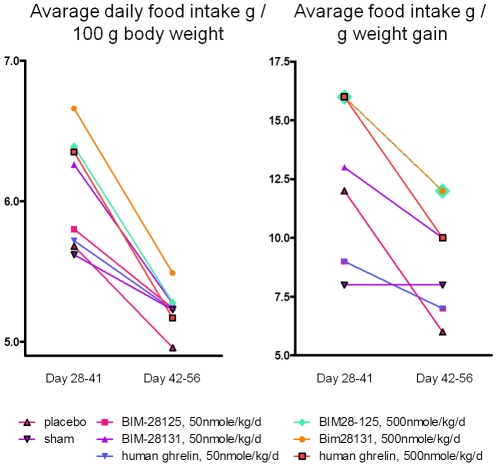
Effect of ghrelin compounds on food intake.A) food intake relative to overall body weight; B) gain of body weight relative to food intake.